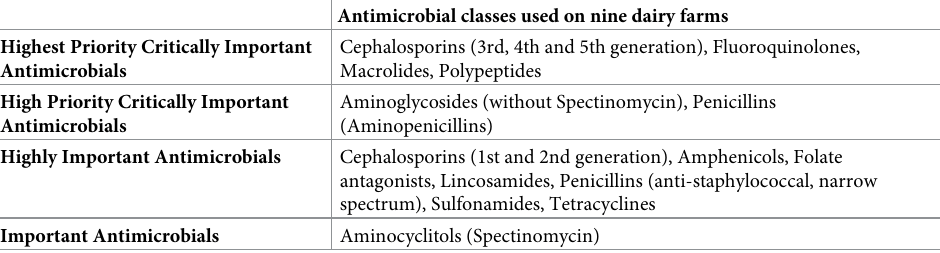
Table 3. Antimicrobial classes used according the WHO classification. Antimicrobial classes used on nine dairy farms Highest Priority Critically Important